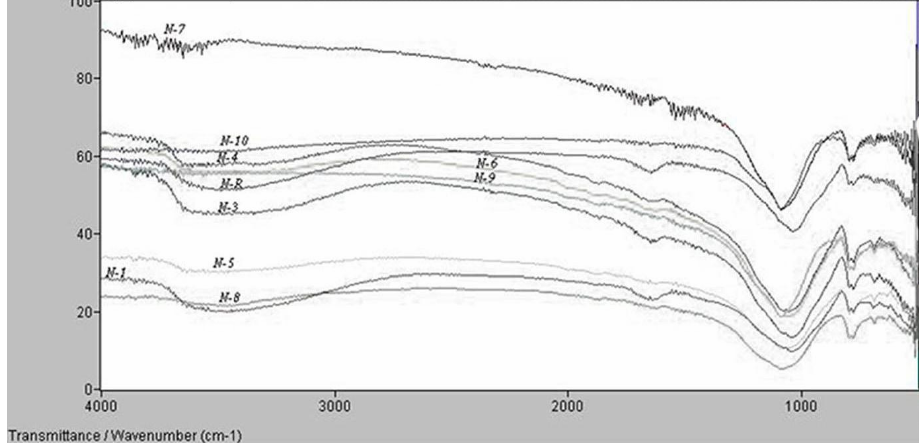
Figure 1. Typical FT-IR spectra of ancient potteries Table 1. Observed absorption frequency in the region of 400-4000 cm -1 S.